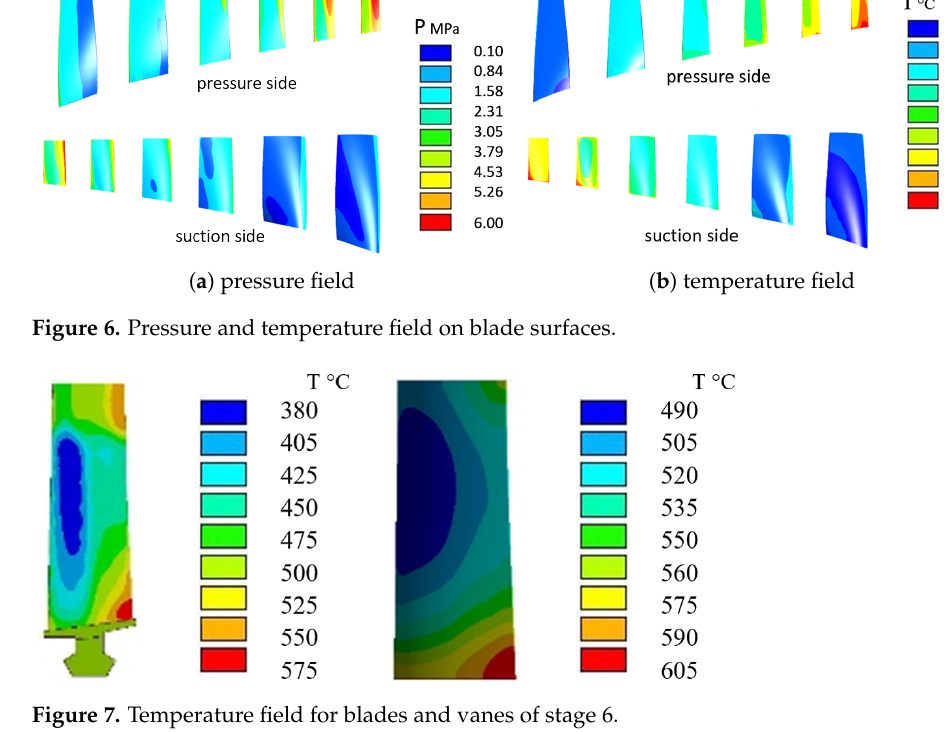
Figure 7. Temperature field for blades and vanes of stage